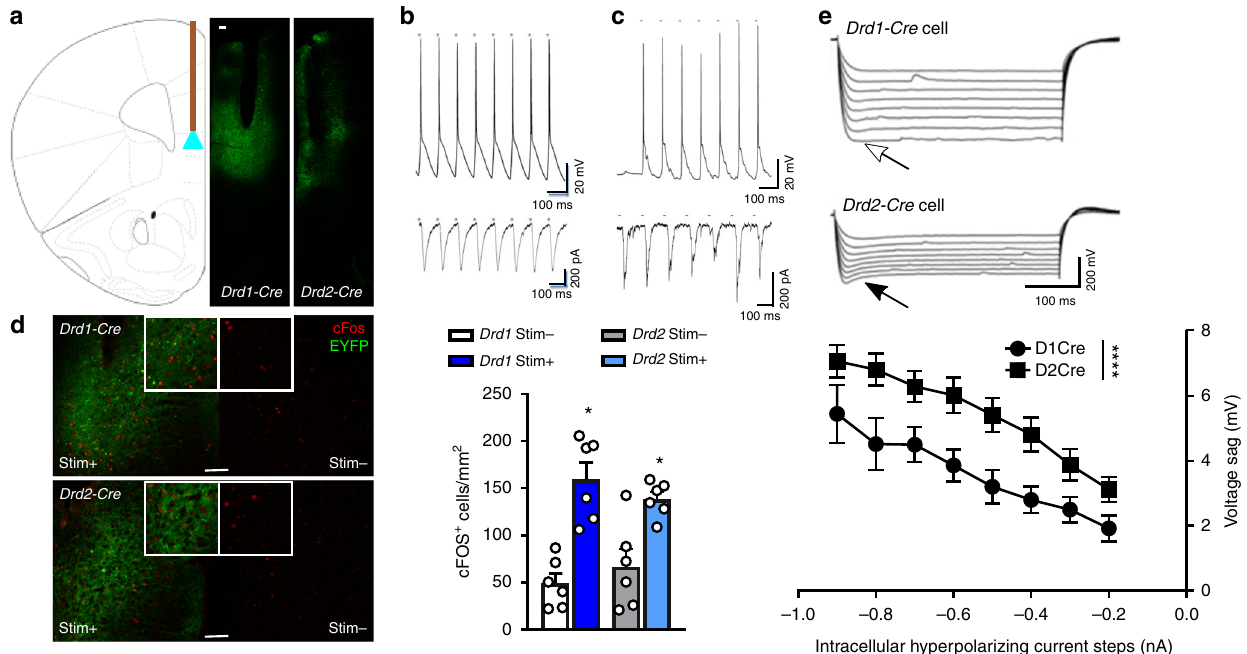
Fig. 1 Cre-dependent targeting of Chr2 to pyramidal cell subtypes in the mouse mPFC. a mPFC targeting strategy and representative images of Chr2 expression and cannula placement in Drd1-Cre and Drd2-Cre mice. b , c Action potential generation and inward current produced by light activation in Drd1- Cre and Drd2-Cre pyramidal cells, respectively. d Unilateral stimulation of Chr2 in Drd1-Cre and Drd2-Cre mice produces similar increases in cFos expression (normalized cells per mm 2 ) in the stimulated hemisphere that are greater than those observed in the unstimulated hemisphere (Wilcoxon matched pairs signed rank, * p < 0.05 vs. respective stim − , n = 6 males/group). e Light-sensitive pyramidal cells in Drd1-Cre mice demonstrate lower voltage sag (open arrow) upon current injection than light-sensitive pyramidal cells in Drd2-Cre mice (closed arrow) (Factorial ANOVA, group **** p < 0.0001, Drd1-Cre 9 cells/2 male animals, Drd2-Cre 10 cells/3 male animals). Error bars represent mean ± SEM, scale bar 100 µ